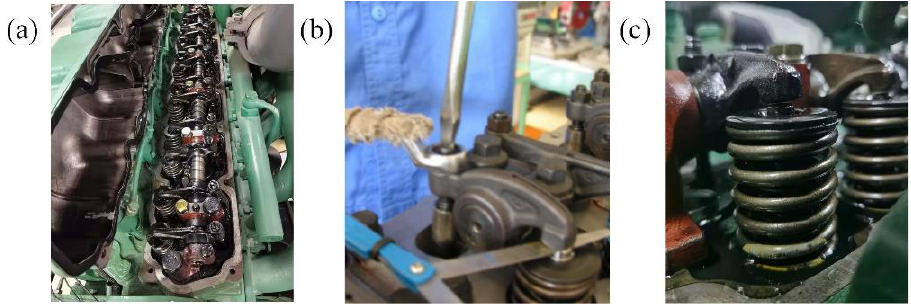
Figure 9. Valve clearance adjustment process: ( a ) cylinder head is removed; ( b )a valve clearance is adjusted; ( c ) the adjusted valve clearance.